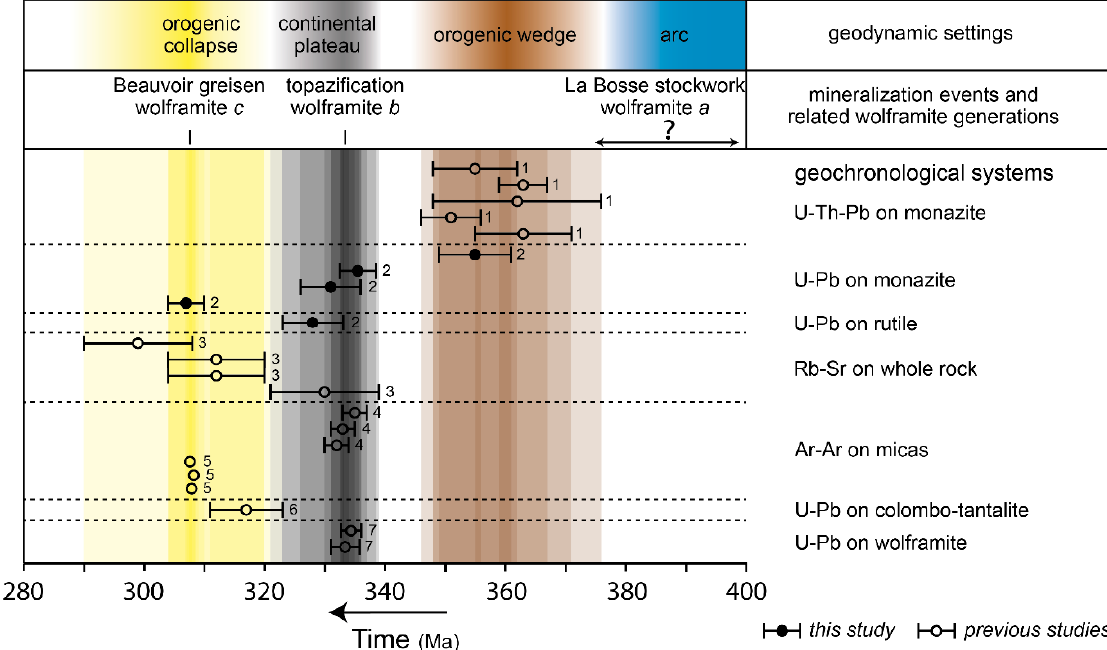
Figure 5. Compiled ages of various formations from the Sioule nappe. 1: monazite from main metamorphic facies [23]. 2: result from this study. 3: whole rock ages (from oldest to youngest) of the Pouzol ‐ Servant, Colettes, and Beauvoir (unit 1 and 2) granites [37,39]. 4: micas from main metamorphic facies [38]. 5: igneous lepidolite of the three main units of the Beauvoir granite [40]. Symbols are larger than error bars. 6: Colombo ‐ tantalite in the Beauvoir granite greisen [41]. 7: Wolframite b ([57]; identification by [44]). The question mark for the wolframite ‐ a age indicates that this generation was only constrained in relative terms, as no absolute age is available for this event in the district, to date.